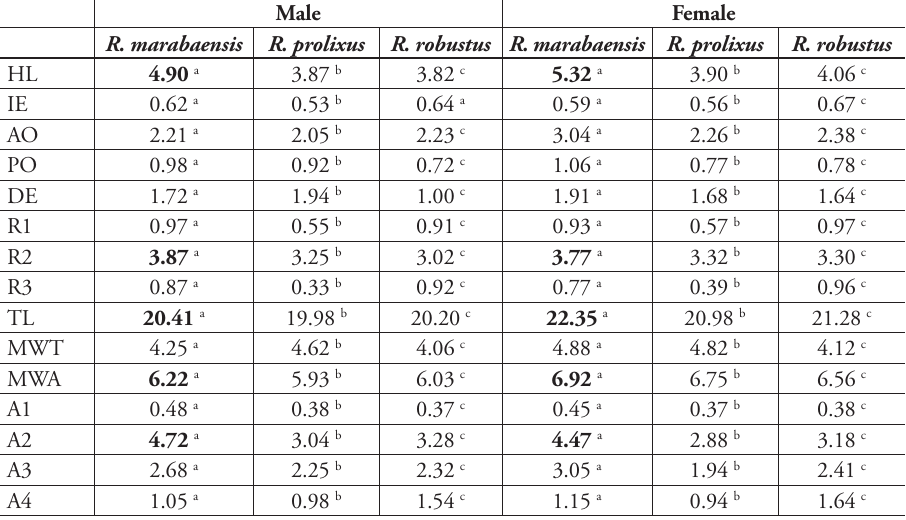
Table 1. Mean of measurement (mm) of 15 females and males of R. marabaensis sp. n., R. prolixus , and R. robustus .